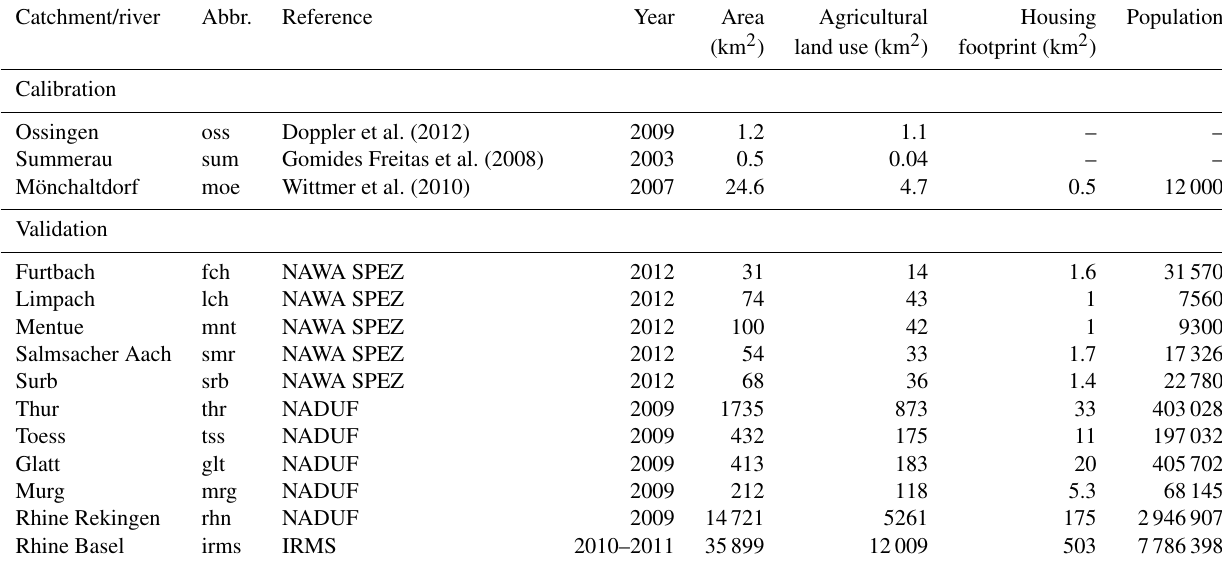
Table 2. Characterization of calibration and validation catchments. NADUF: National long-term surveillance of Swiss rivers, NAWA SPEZ: NAWA SPEZ: National Surface Water Quality Monitoring Programme – Special Campaigns, IRMS: International Rhine Monitoring Station